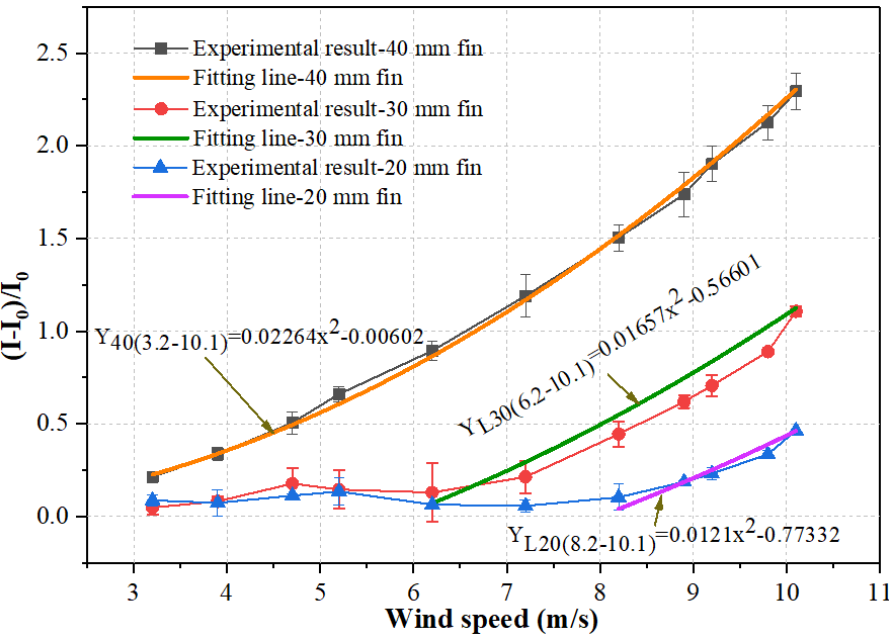
Figure 8. Relationships between the current variations and wind speed under different fin sizes.